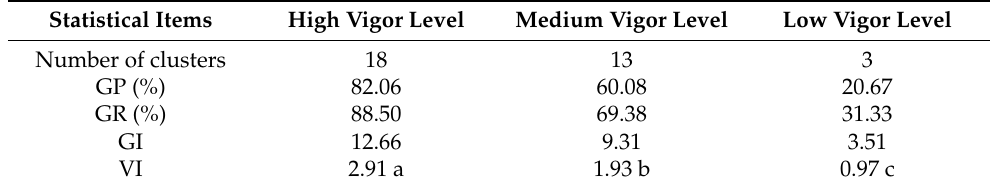
Table 4. Number of genotype clusters and their mean values of the vigor indexes of 34 soybean strains included in the regional test in Huanghuaihai, China, in 2021. Statistical